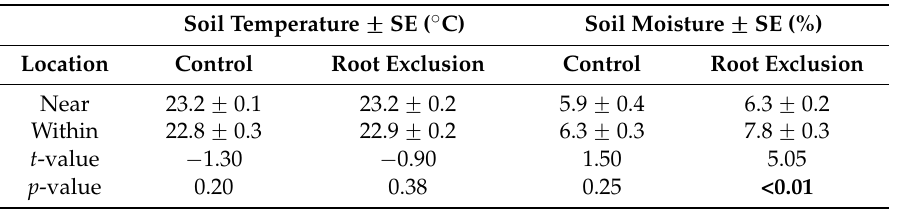
Table 2. Influence of location on soil temperature and moisture measurements ( i.e. , within or near soil respiration collars) for control collars and root exclusion tubes measured in three 26-year-old longleaf pine ( Pinus palustris Mill.) stands. Bolded p -values are significant at α = 0.05.